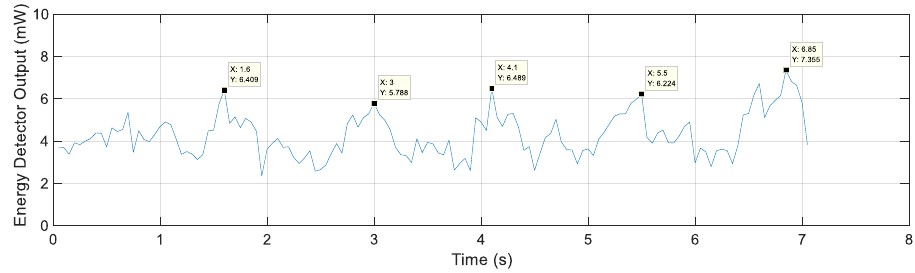
Figure 10. Energy detector output for Scenario 3.